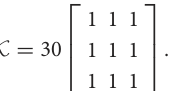
TABLE 1 Performance comparison of event-triggered